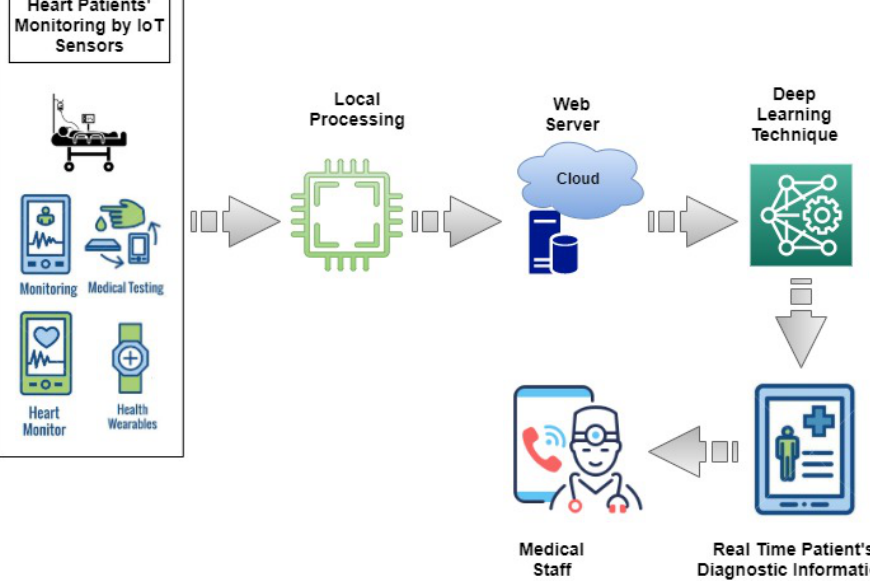
Figure 1. Smart Healthcare Framework to monitor heart-failure